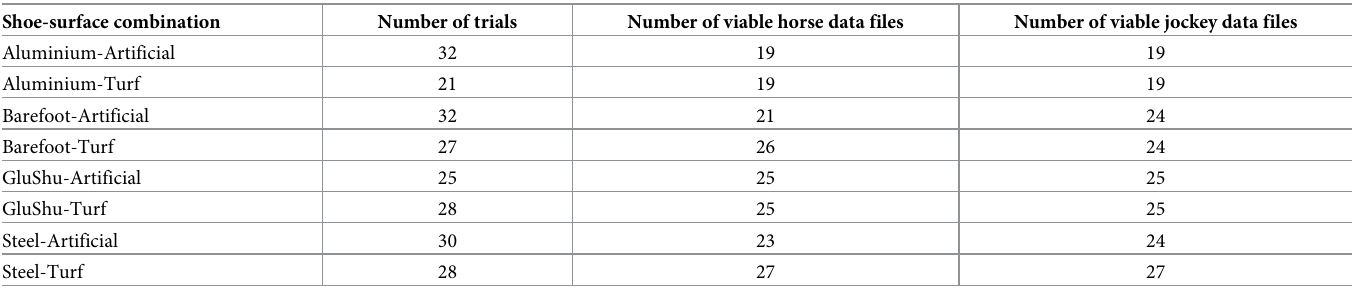
Table 1. Number of gallop runs analysed for each shoe-surface combination.